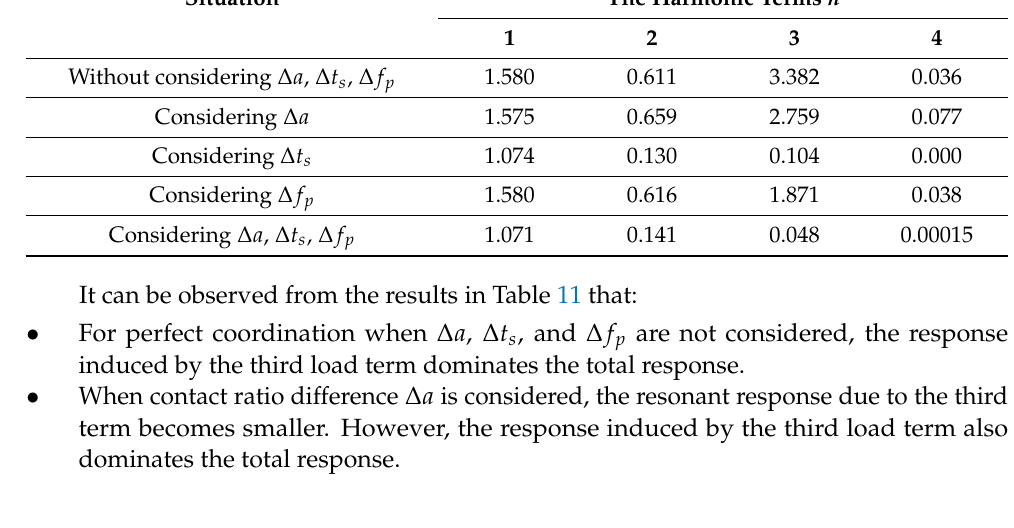
The coefficient s n is the harmonic term coefficients to the mean of the random dis- .. s n to the mean of the random acceleration placement A R ( t ) , and of each of the harmonic terms to the displacement and acceleration, respectively, are shown in Tables 11 and 12. Table 11. Displacement response contributions from each of the harmonic terms.